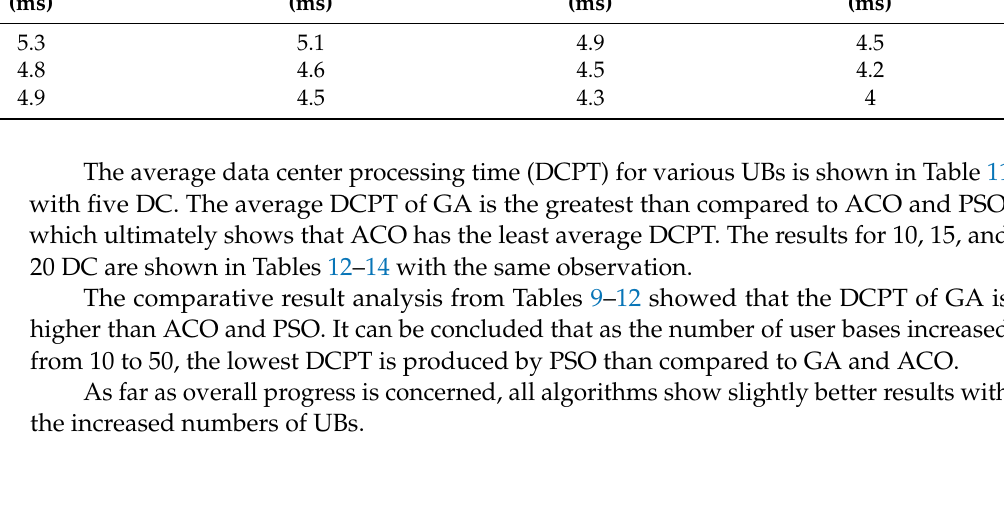
Table 14. Performance analysis of avg. DCPT for 10, 20, 30, and 50 UB with 20 DC.